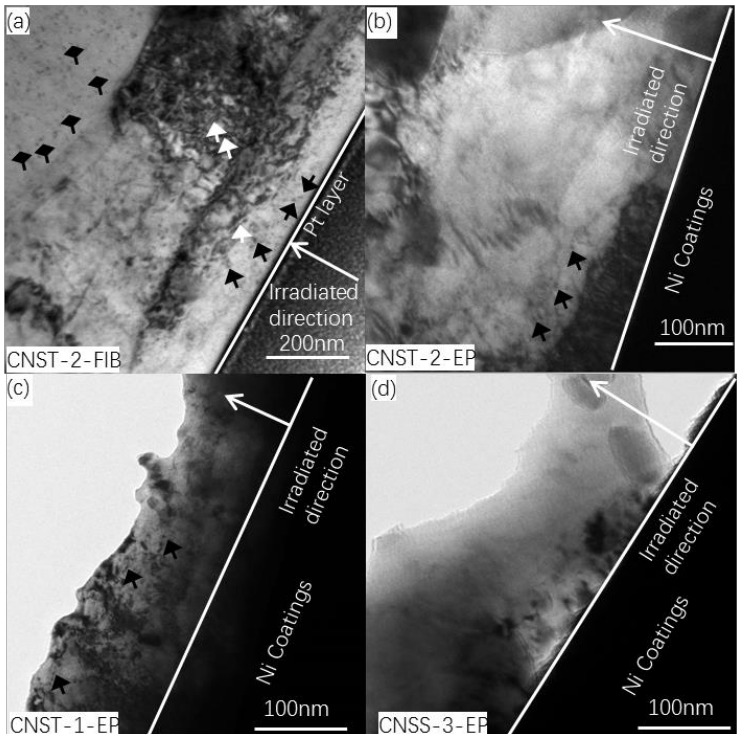
Figure 4. Bright field TEM images showing the microstructure of the cross-sectional samples irradiated with a fluence of 7.0 × 10 14 Fe + /cm 2 , ( a ) CNST2 sample prepared with FIB; ( b – d ) CNST2, CNST1 and CNSS3 samples prepared by ETE method.